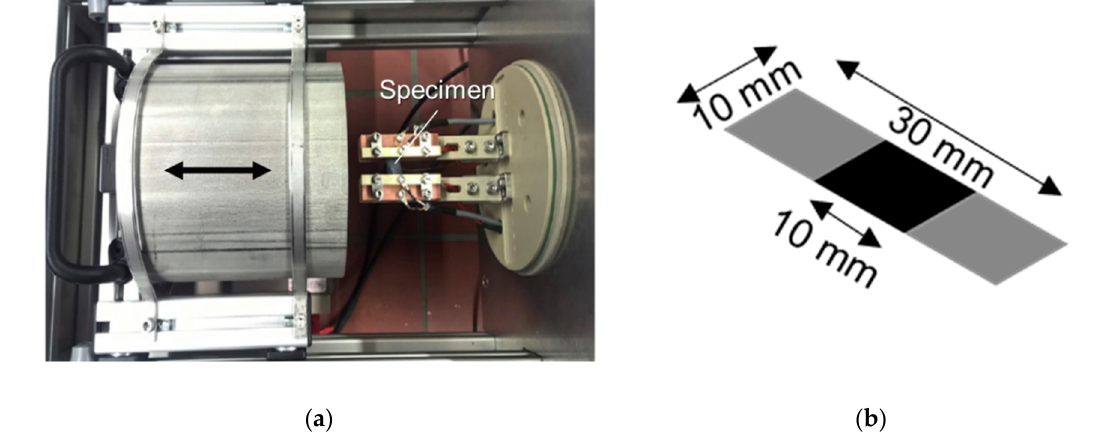
Figure 8. Picture of ( a ) Seebeck measuring device and ( b ) scheme of specimen for thermoelectrically measurements with a thickness of 0.5–0.9 mm (the thickness depends on the manufacturing